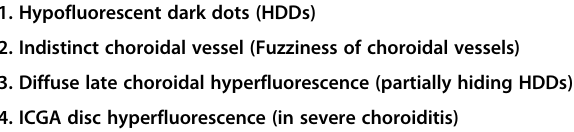
Table 2 ICG angiographic signs in stromal